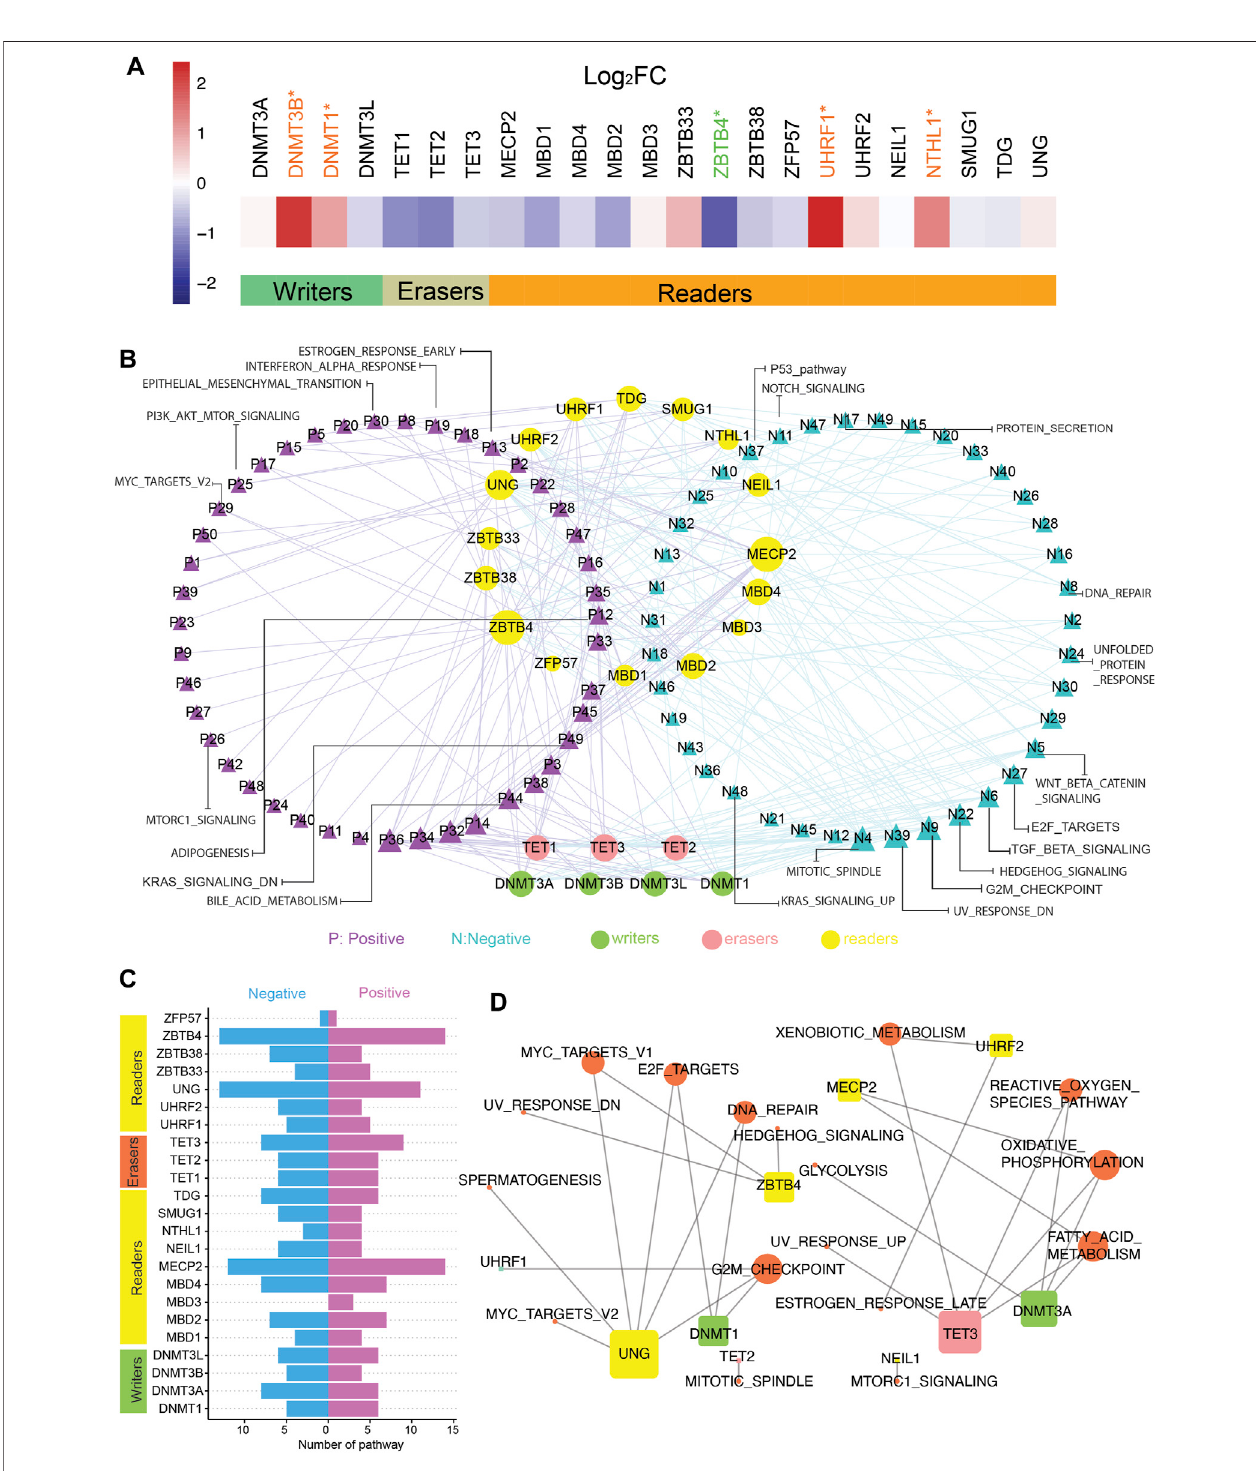
FIGURE 1 | Active and suppressive pathways of cancer are associated with 5mC regulators in colon cancer. (A) Gene expression of 5mC regulators in tumor and normal samples. t -test was used to evaluate differences between two groups, * p -value < 0.05. (B) Network pictogram for hallmark-related pathways and 23 5mC regulators based on GSVA and correlation. Size of nodes is in proportion to number of related links. (C) Number of pathways correlated with individual 5mC regulators. (Right: positively correlated pathways; left: negatively correlated pathways.). (D) Pathways highly related with 23 5mC regulators (|SCC| > 0.5 and p -value < 0.05). Size of nodes is in proportion to number of related